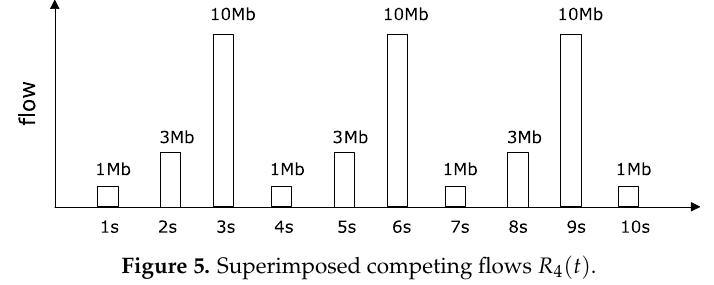
Figure 5. Superimposed competing flows 𝑅 4 (𝑡) .